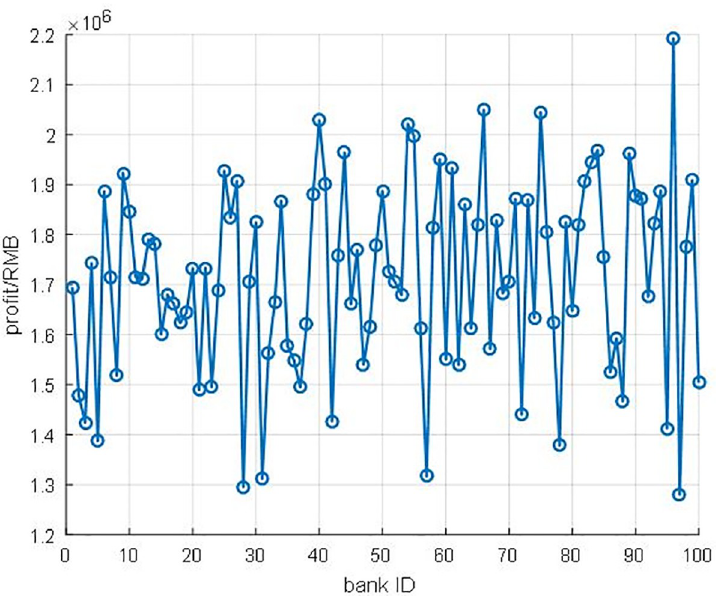
Fig 14. The total money out of